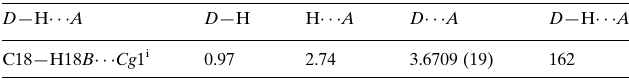
Hydrogen-bond geometry (A˚ , (cid:2)